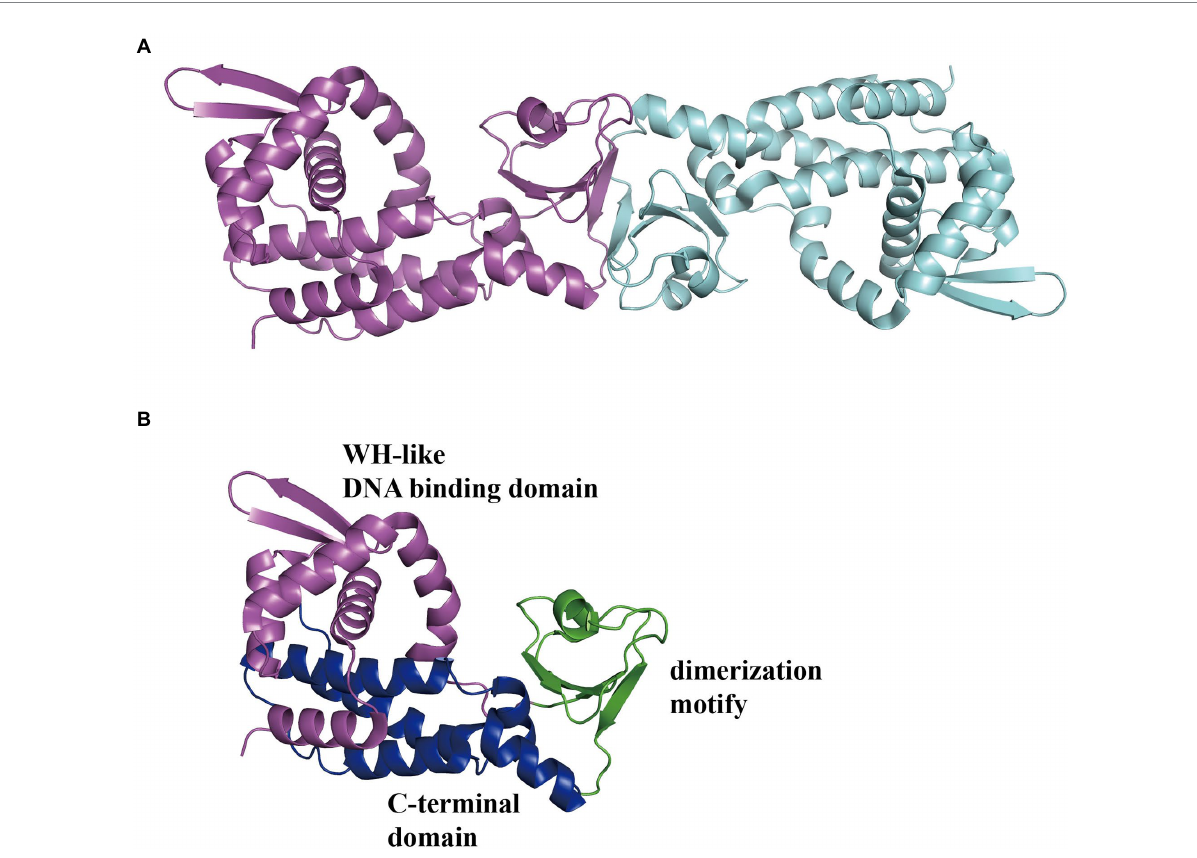
FIGURE 11 Overall structure of PaaX. (A) The overall structure of dimer Jccs1PaaX (PDB:3 L09) is shown in a different color for each chain. (B) The PaaX could be divided into three regions as an N-terminal Winged helix-like DNA-binding domain, a dimerization motif, and a C-terminal extended domain consisting of five α -helices, shown in magenta, green, and blue,